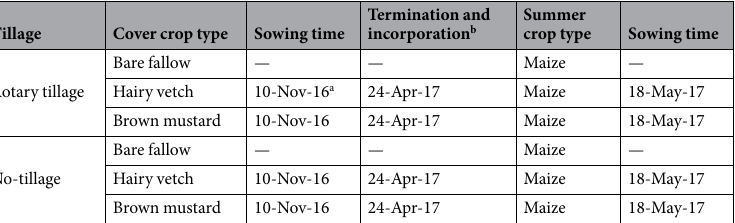
Table 1. Summary of cover crop types and tillage practices in the present experiment. a DD/MM/YY. b A hammer knife mower was used to terminate both cover crops at both tillage management systems. Rotary tillage: the aboveground plant parts of cover crops were incorporated into the soil by a rotary tiller. No tillage: the aboveground plant parts of cover crops remained on the soil